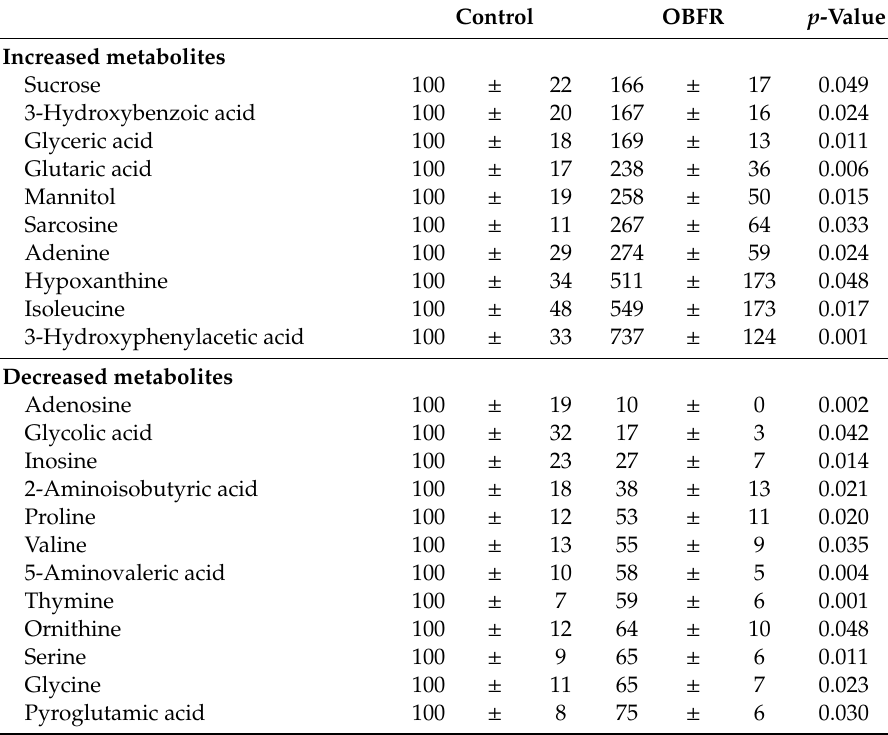
Table 4. E ff ects of feeding OBFR on metabolites in cecal content of rats.